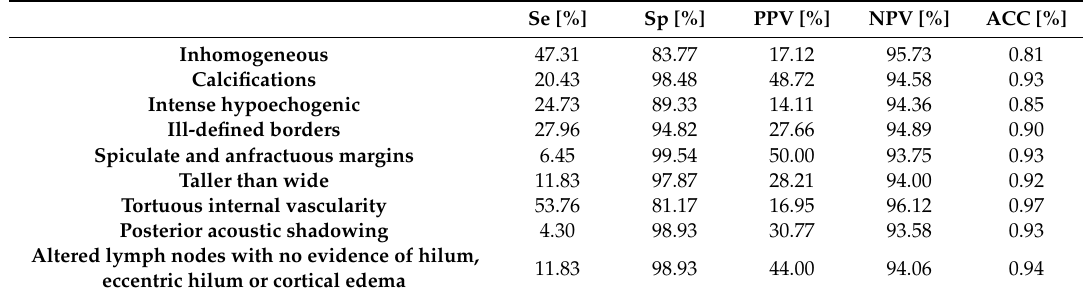
Table 3. Conventional breast ultrasound malignancy markers—diagnostic power (1405 nodules)